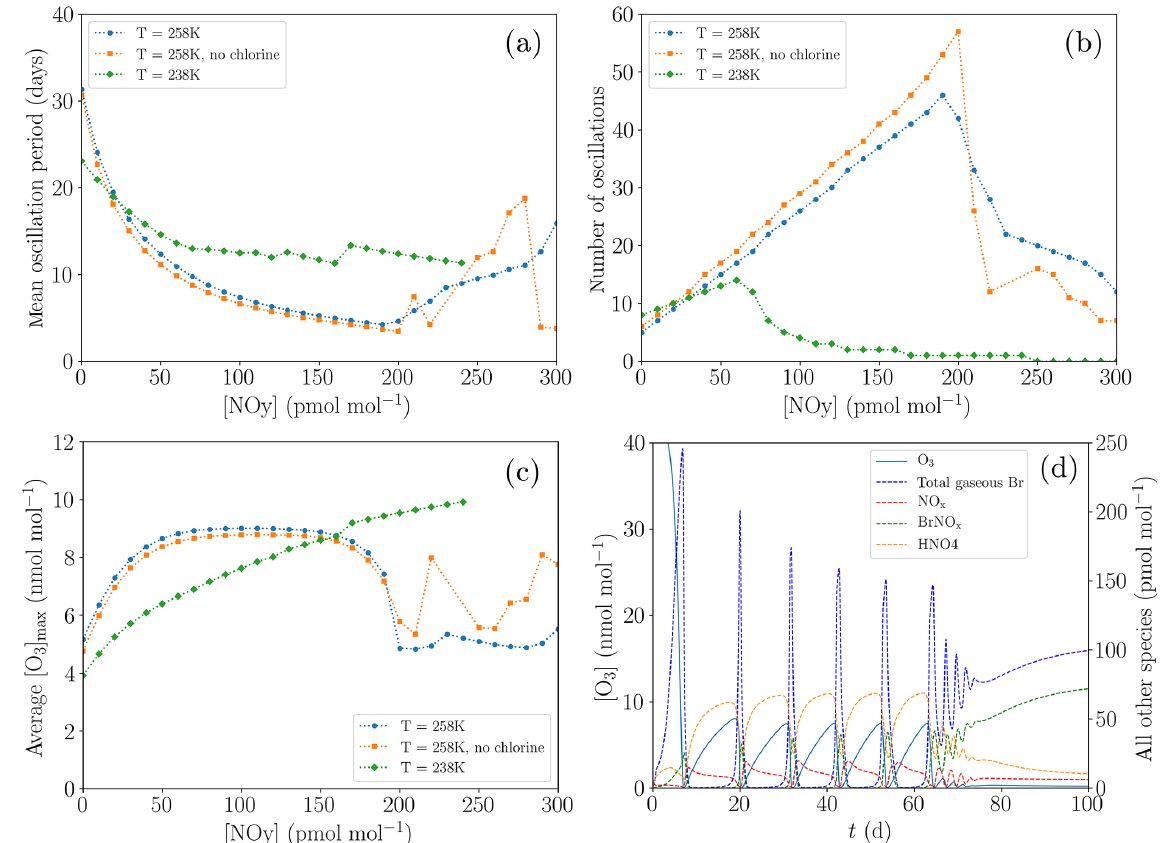
Figure 11. Dependence of the oscillation characteristics on the variations of [NO y ] (a–c) . Termination of an ODE: profiles of the mixing ratios of various species for the base settings and for 238K and [ NO y ] = 100pmolmol − 1 (d) . (a) Average oscillation period during 200d. (b) Number of oscillations during 200d. (c) Average maximum mixing ratio of ozone. (d) Profiles of the mixing ratios of O 3 and total gaseous